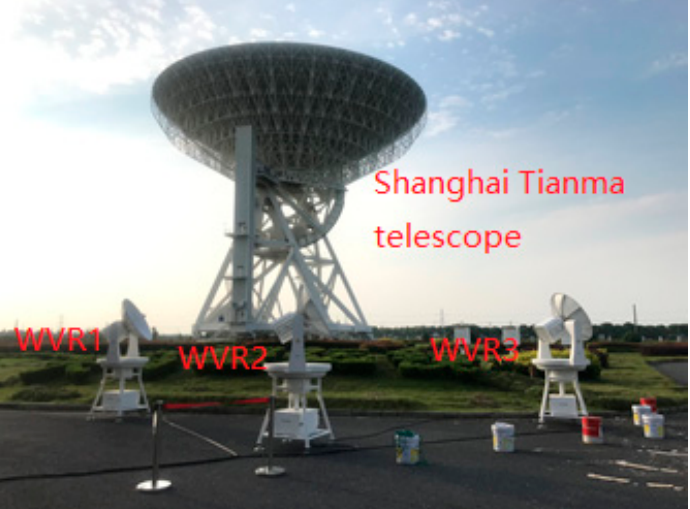
Figure 1. WVR next to the Shanghai Tianma